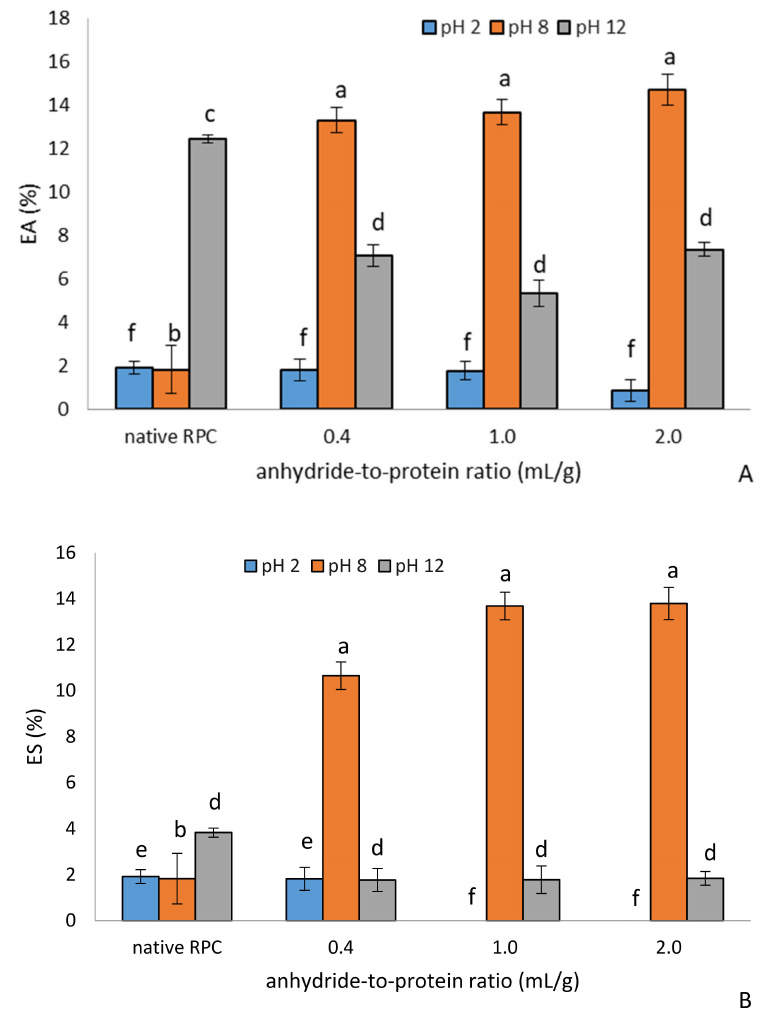
Figure 4. Effect of anhydride-to-protein ratio on emulsion activity, EA ( A ), and emulsion stability, ES ( B ), at different pH for the native and acetylated RPC. a, b—the same letters within pH 8 indicate values that are not significantly different; c, d—the same letters within pH 12 indicate values that are not significantly different; e, f—the same letters within pH 2 indicate values that are not significantly different; RPC—rice protein concentrate; 0.4, 1.0, 2.0—rice protein preparations after acetylation conducted with different concentrations of acetic anhydride